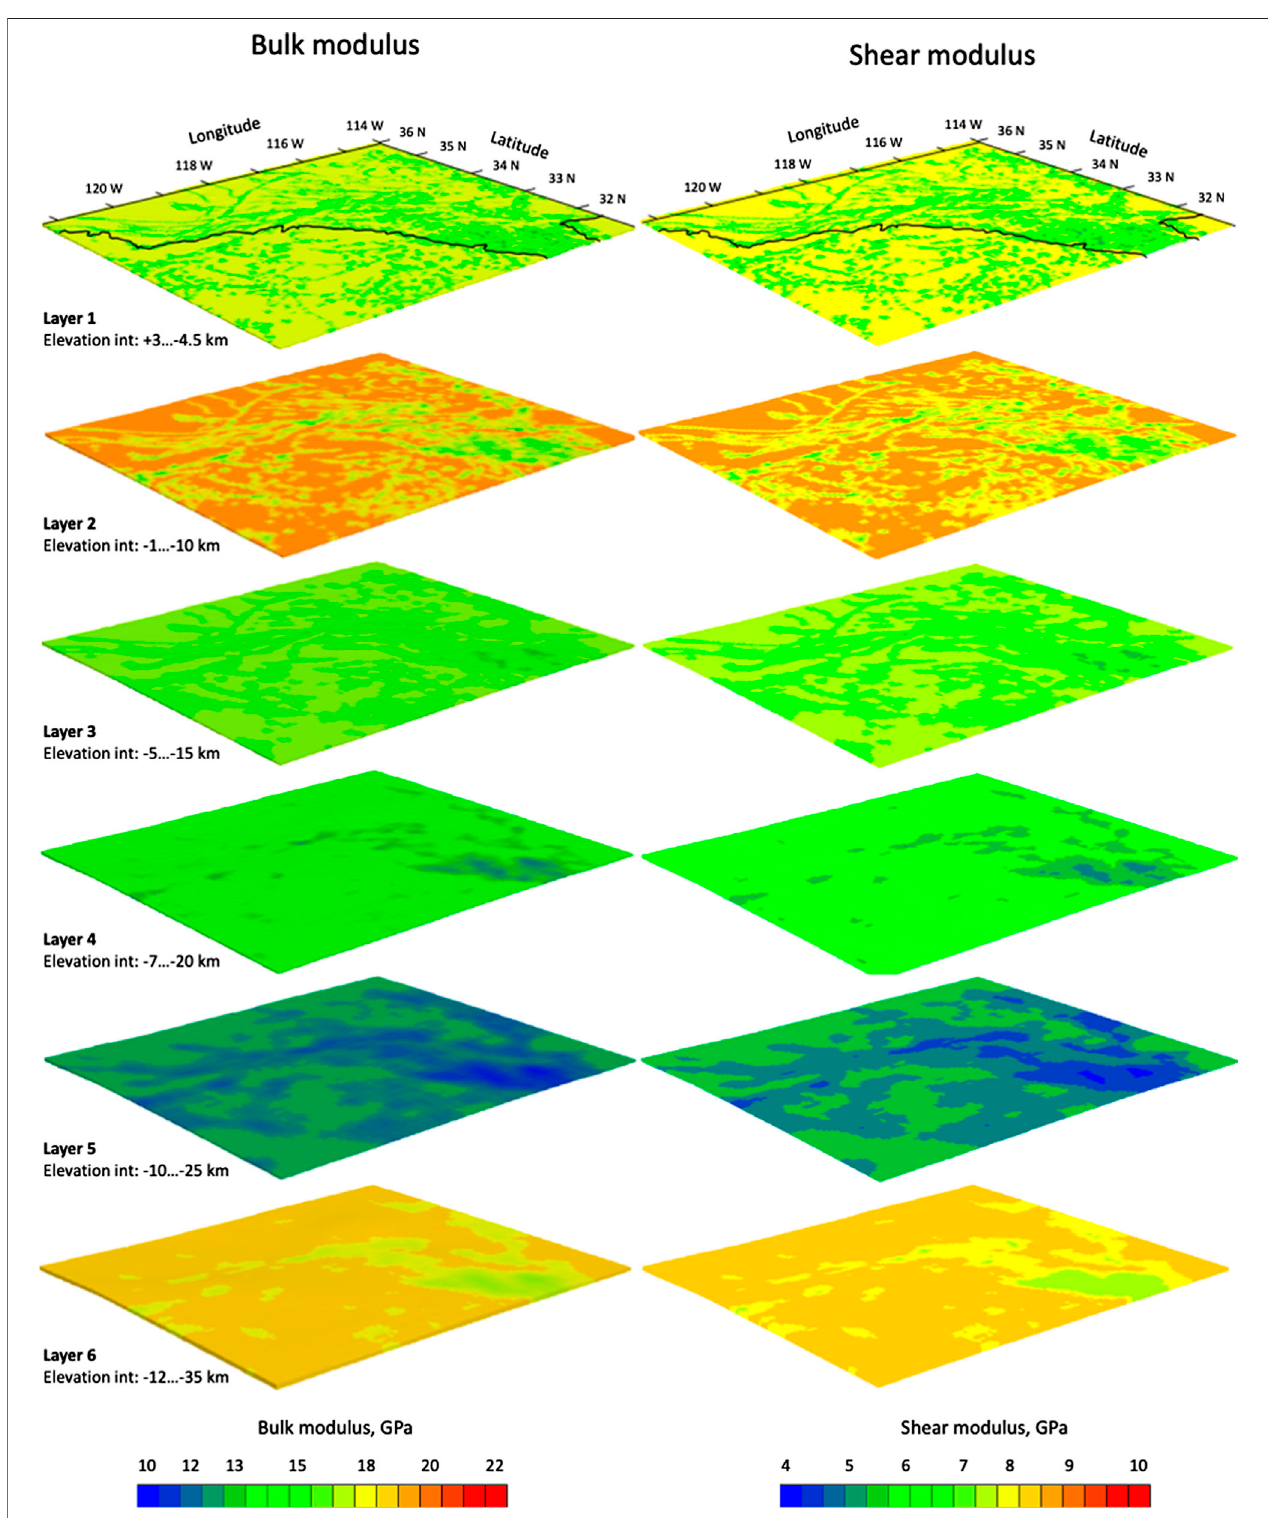
FIGURE 3 | Initial model properties for six crustal layers: bulk (left column) and shear (right column) moduli distributions. Heterogeneous patterns re fl ect fault tectonics and reduced strength (assumed using the so-called damage function).